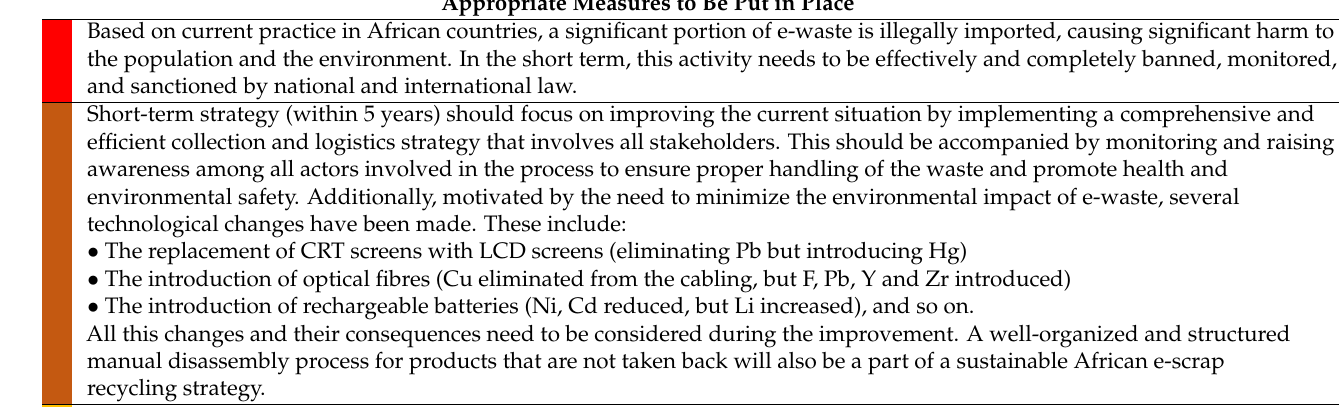
Table 6. Current, short-, middle-, and long-term solutions of e-waste problem. Appropriate Measures to Be Put in Place